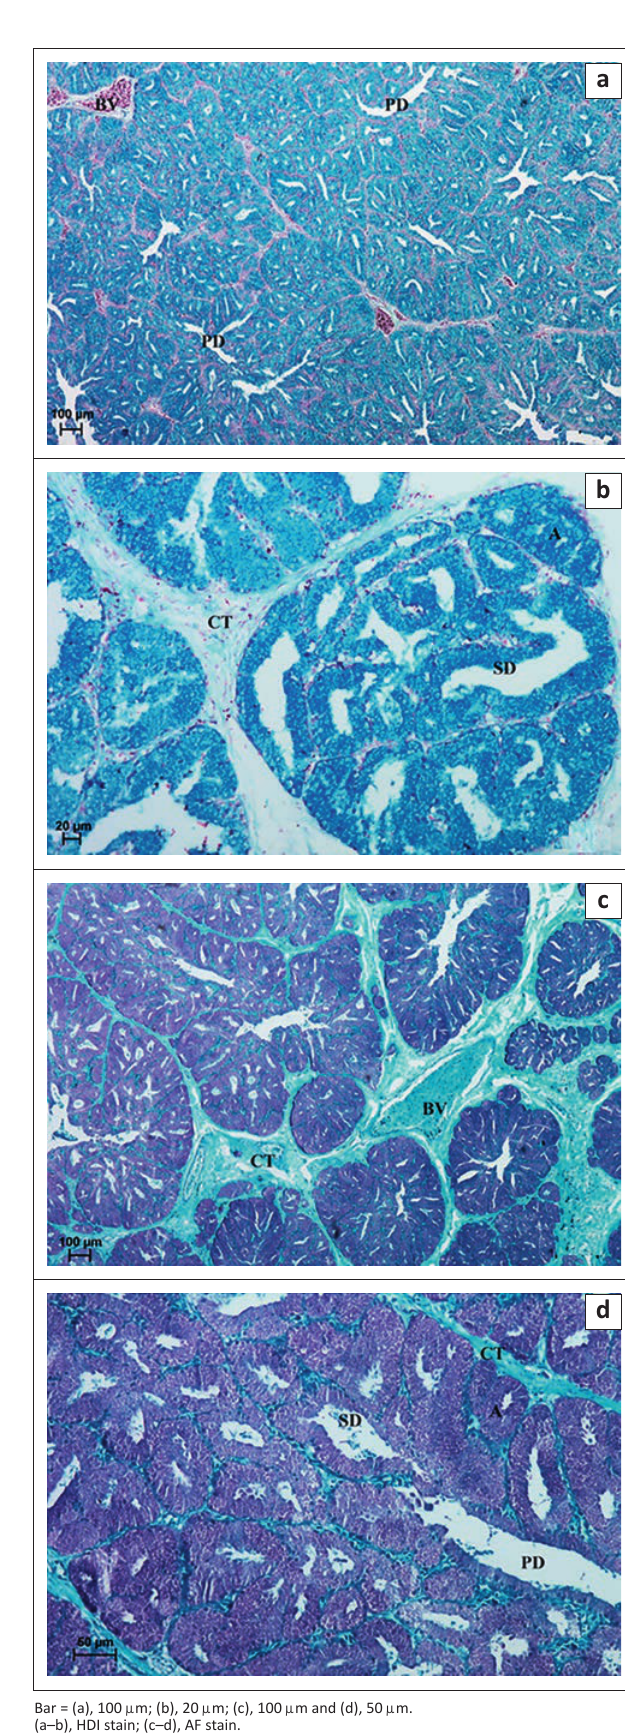
FIGURE 10: Light micrograph of the lacrimal gland in African black ostrich in group 4. (a) 7-months-old, (b) 5-months-old, (c) 6-months-old and (d)